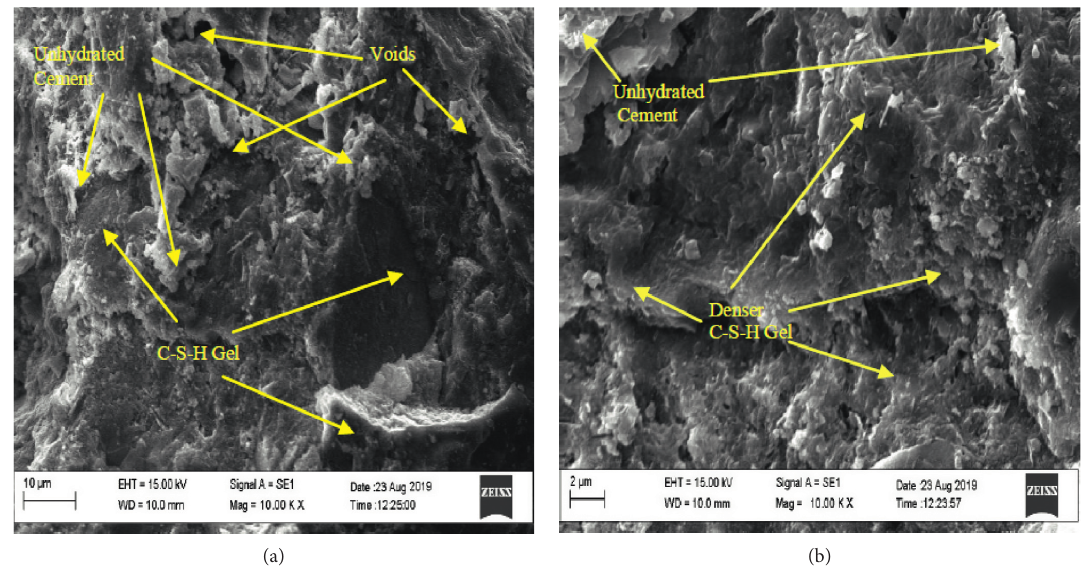
Figure 6: SEM micrographs. (a) Control sample CM. (b) Binary sample C80S20.